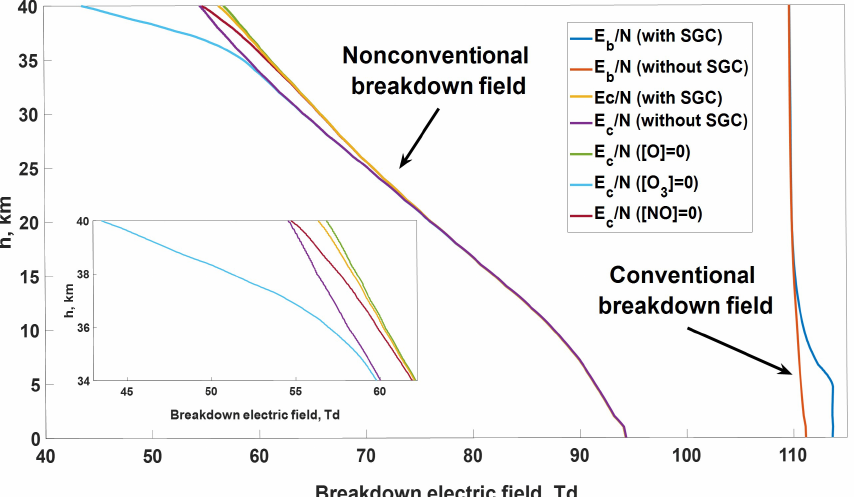
Figure 2. Altitude profiles of conventional ( E b / N ) and critical ( E c / N ) reduced electric fields cal- culated for different atmospheric air compositions. At the bottom left part, the insertion shows an enlarged fragment of the nonconventional reduced breakdown field altitude dependence where its profile splits into several modes corresponding to different types of air composition.